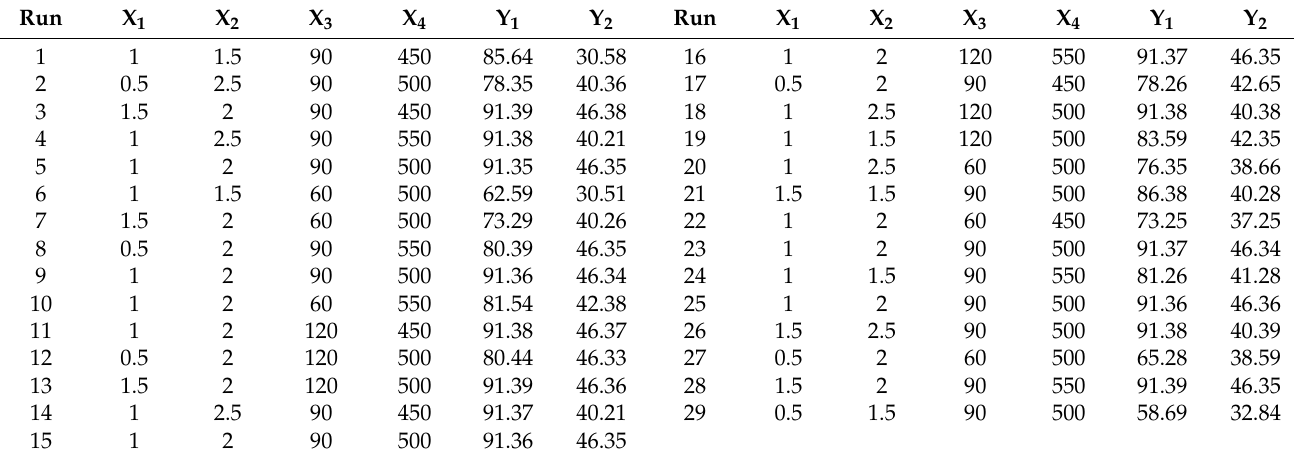
Table 3. Experimental design matrix and results.